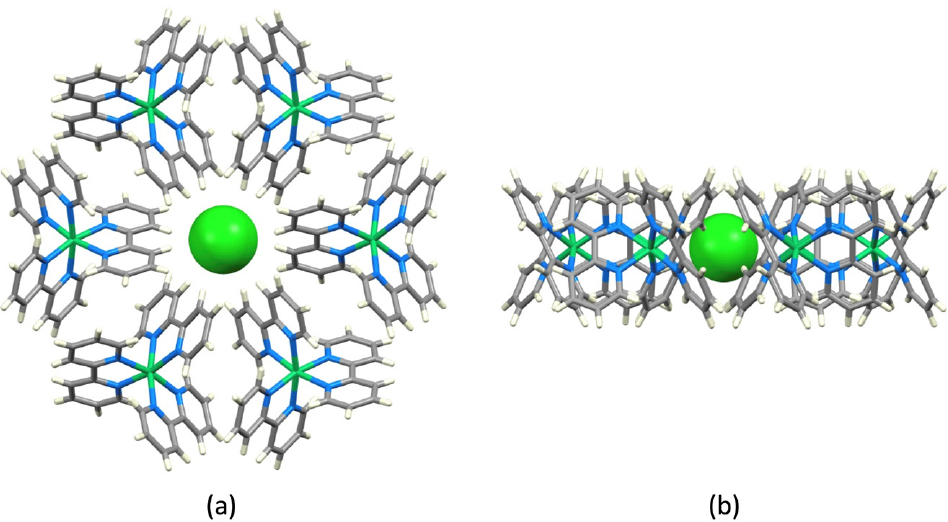
Figure 1. The halide embrace exemplified with the motif observed in [Ni(bpy) 3 ]Cl 2 · 5.5H 2 O, CSD refcode EGOVEB [22]. ( a ) The Cl – ion at the center of a motif of six homochiral [Ni(bpy) 3 ] 2+ cations, and ( b ) a side view of the same motif; this unit is part of a 2D-sheet.